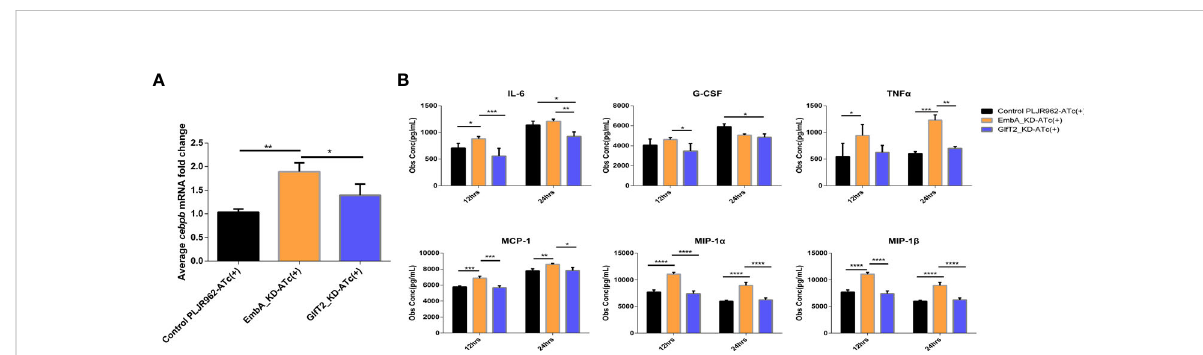
FIGURE 7 Validation of cebpb expression and secreted regulatory cytokine levels in an infected macrophage. (A) Real-time polymerase chain reaction was used to verify the mRNA expression level of cepbp in the corresponding sample of transcriptomes (from macrophages infected with multiplicity of infection = 5 and 12 h). Data were plotted as mean ± SD, unpaired t -test: * p = 0.0465 and ** P = 0.0018. (B) Cytokine contents in the cell supernatant of macrophage J774A.1 infected by control PLJR962 strain and EmbA_KD strain with MOI = 5. Two-way ANOVA tests are used for all signi fi cance analysis here: ** P < 0.01, ** P < 0.01, *** P < 0.001, and **** P <